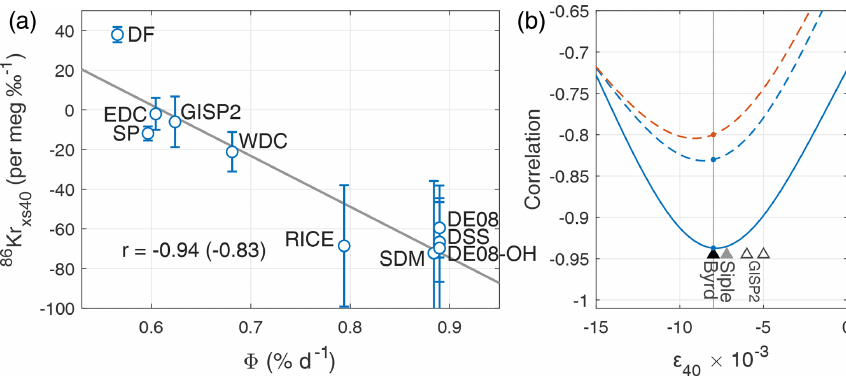
Figure 3. Calibrating Kr-86 excess. (a) 86 Kr xs as a function of (cid:56) for the calibration dataset. Circles give the site mean, and the error bars denote the ± 1 σ standard deviation between samples (uncertainty in corrections and measurements not included). The number of samples at each site is given in Table 1. The Pearson correlation coefficient is r = − 0 . 94 when considering site data means and r = − 0 . 83 when considering all individual samples. Data are corrected for gas loss using ε 40 = − 0 . 008 (Appendix A1) and corrected for thermal fractionation using site mean 15 N excess (Appendix A2). The calibration curve for 86 Kr xs15 is identical in this case, with slightly larger error bars. (b) Correlation of the calibration curve as a function of the gas loss correction scaling parameter ε 40 . The solid line gives the correlation for both site mean 86 Kr xs15 and 86 Kr xs40 (identical); the dashed lines show the correlation using individual samples for 86 K xs40 (blue) and 86 Kr xs15 (orange). Triangles denote the ε 40 estimate from the Byrd, Siple, and GISP2 ice cores (Fig. A2; Kobashi et al., 2008a; Severinghaus et al.,